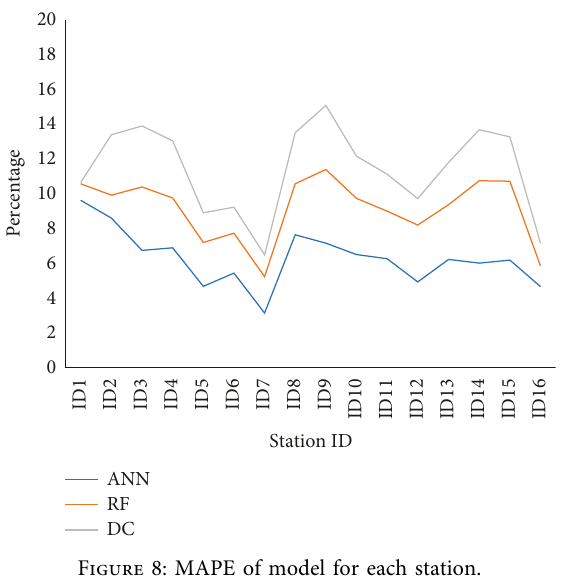
Figure 8: MAPE of model for each station.